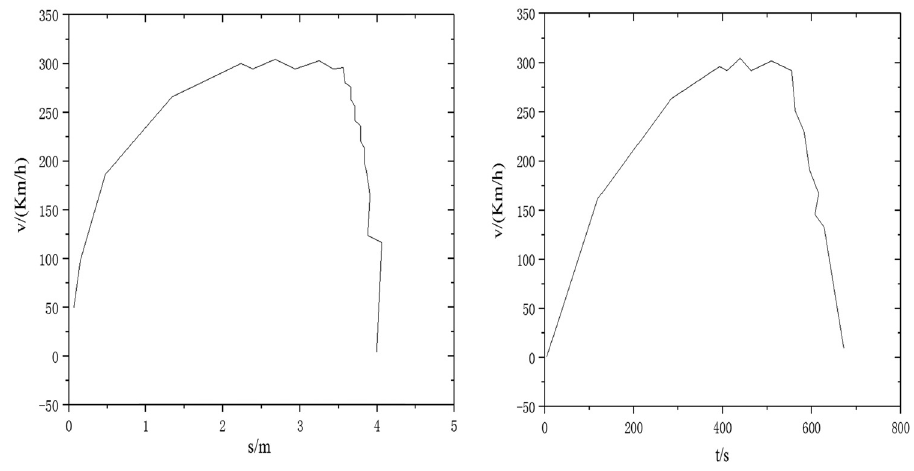
Figure 3: Running curve on the